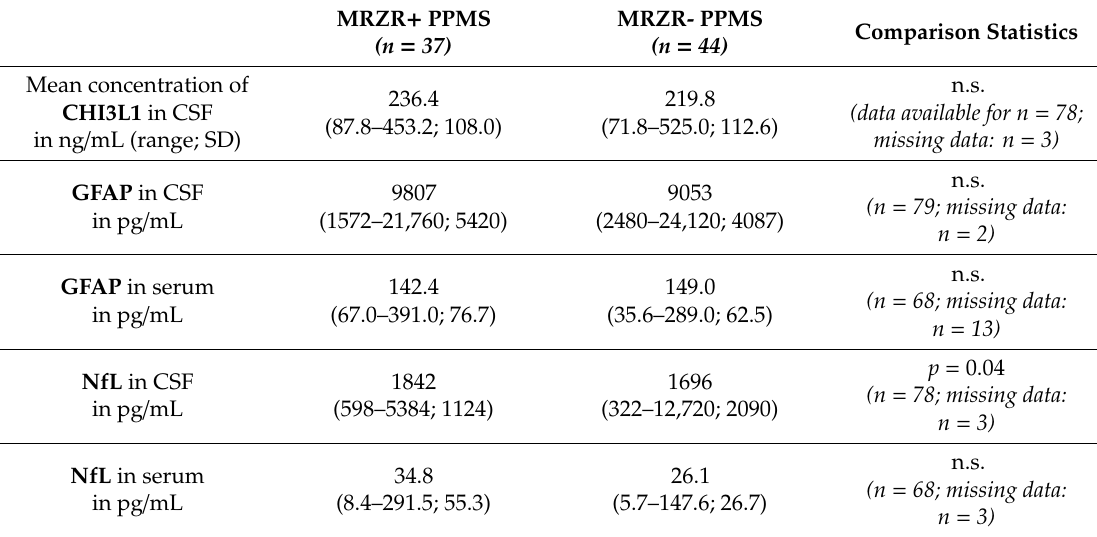
Table 4. Biomarkers of glial activation and neuroaxonal damage.